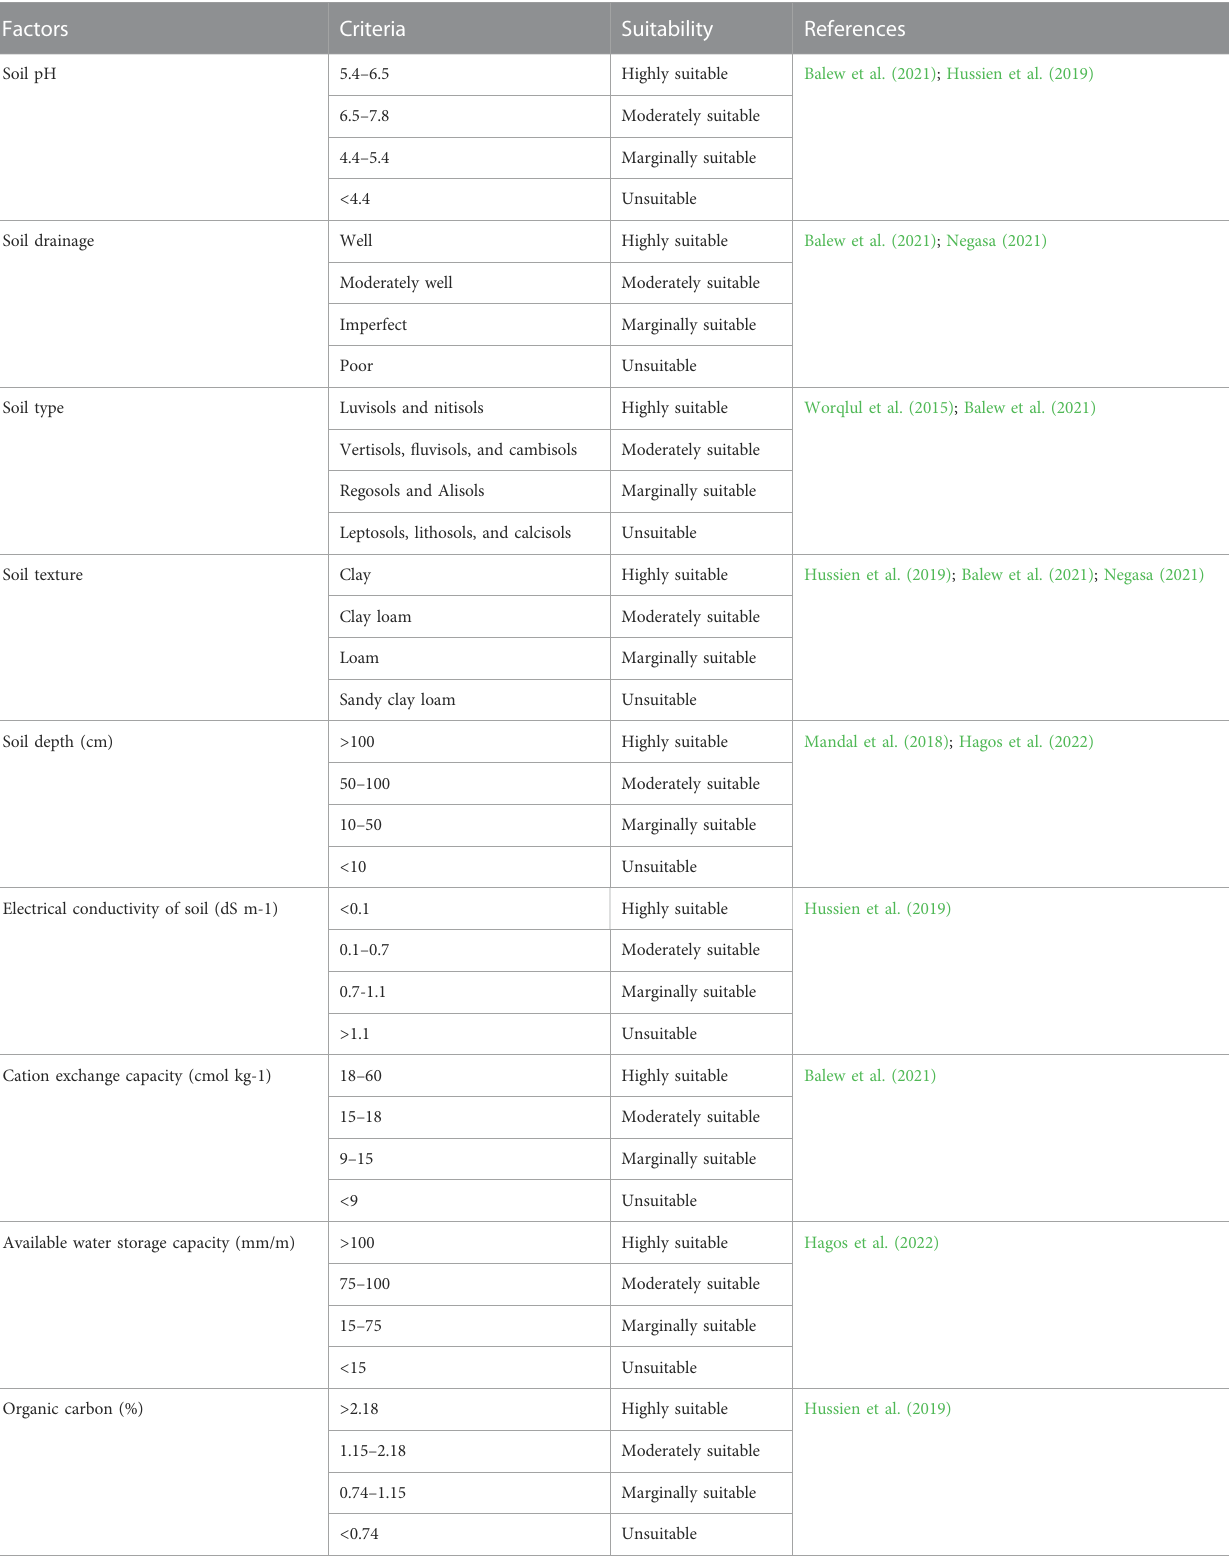
TABLE 3 Assessment of soil related surface irrigation suitability